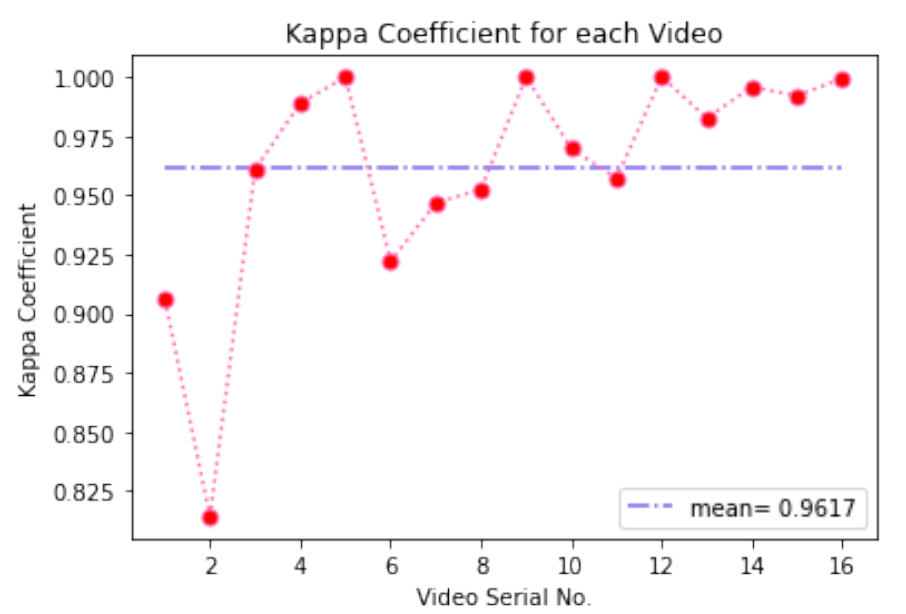
Figure 6. Cohen’s Kappa Coefficient plotted against mean value of